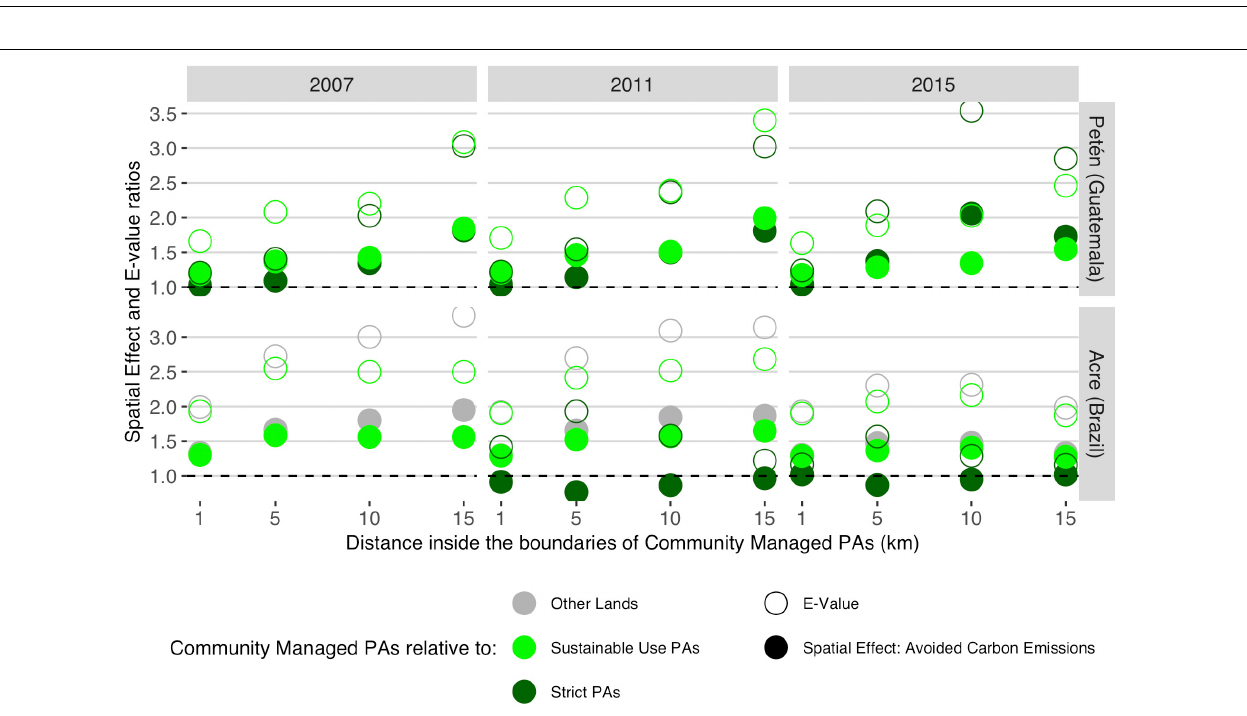
FIGURE 8 | Sensitivity analysis in the spatial effects of Community Managed PAs on carbon stocks in Petén (Guatemala) and Acre (Brazil). The spatial effect ratio (unitless) is equivalent to the probability of a positive spatial effect in the treatment (i.e., Community Managed PAs) divided by the probability of a positive spatial effect in the controls (i.e., Other Lands, Sustainable Use PAs, and Strict PAs). The E -value represents the minimum strength that an unmeasured covariate would need to have with the treatment and the spatial effect for the treatments and spatial effect association not to be causal.